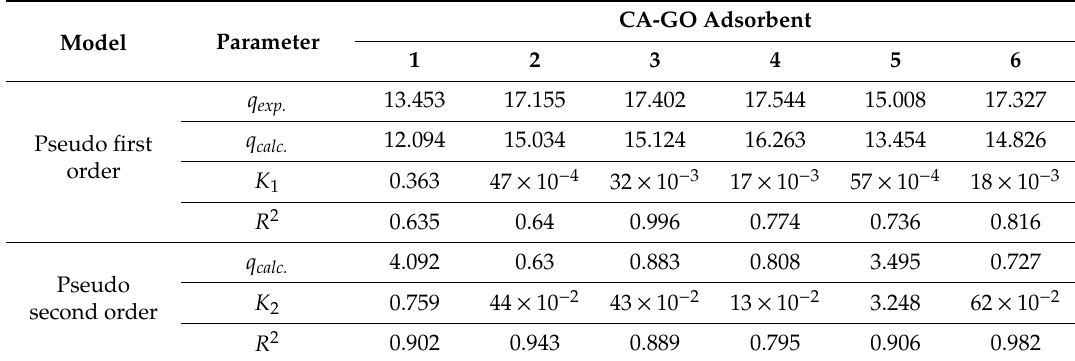
Table 2. Kinetic models of pseudo first order and second order adsorption processes.